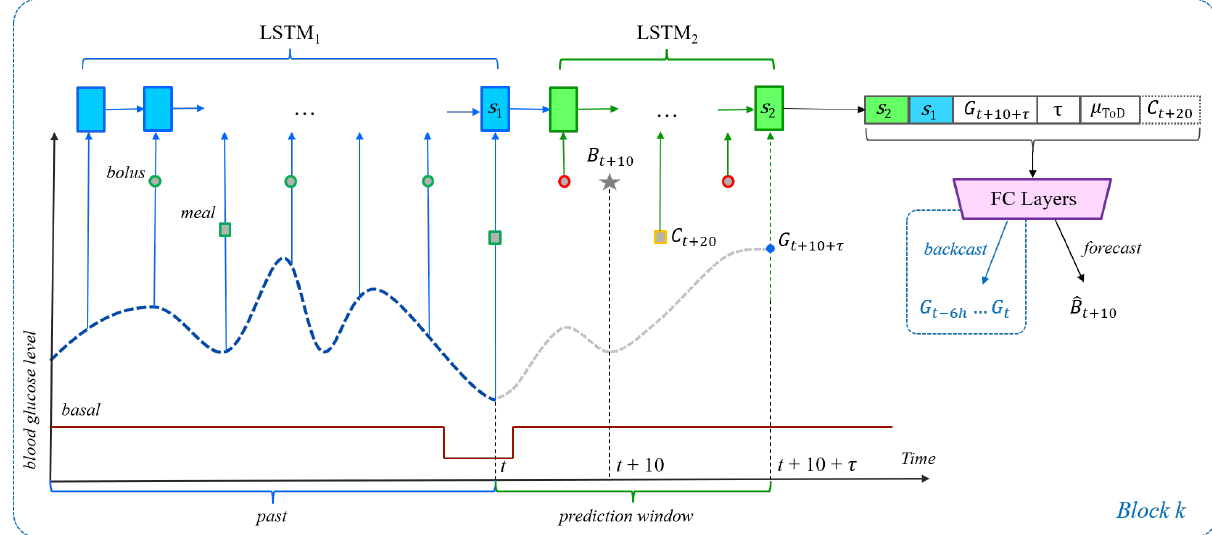
Figure 2. The general neural network architecture for the bolus and bolus given carbs recommendation scenarios. The ar- chitecture itself is similar to that shown in Figure 1. The gray star now represents the bolus at time t + 10. For the bolus recommendation scenario, the events outlined in red or orange are not allowed in inertial examples. However, in the bolus given carbs scenario, the meal event C t + 20 shown with the yellow outline is an important part of each example, be it inertial or unrestricted. As such, in this scenario, the dashed C t + 20 becomes part of the input to the